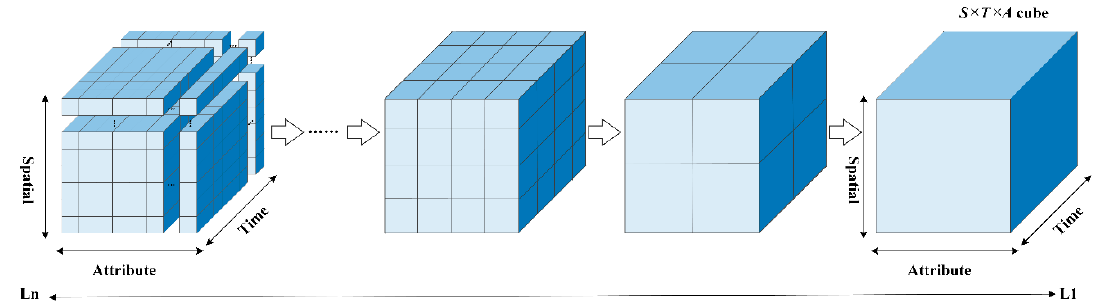
Figure 4. Multidimensional aggregation pyramid model.